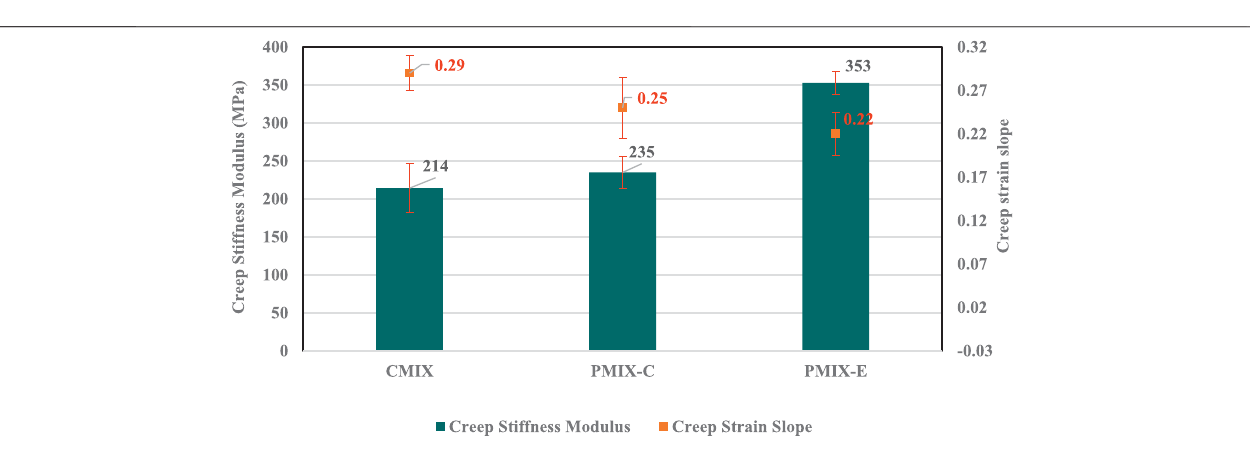
Frontiers in Materials |